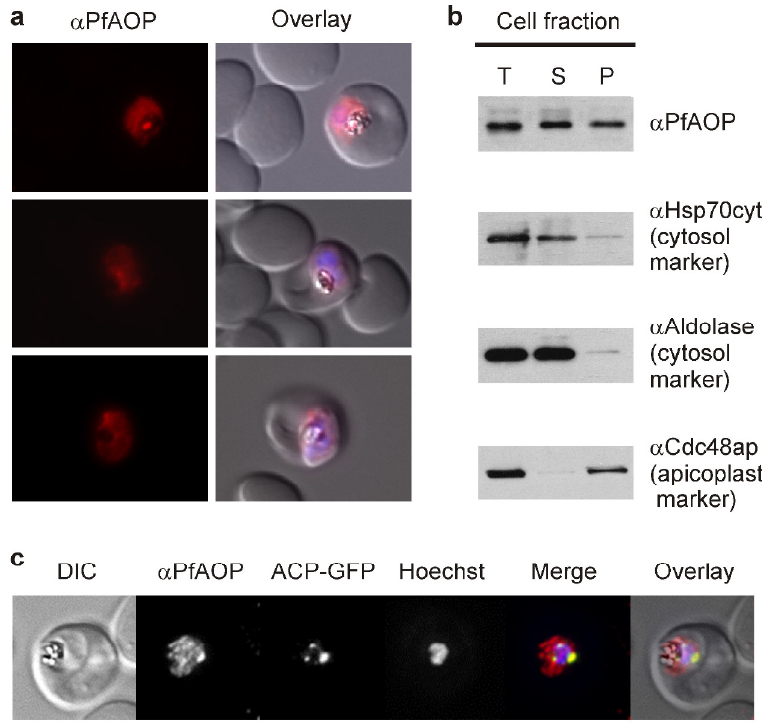
FIGURE 1: Dual localization of PfAOP. (A) Immunofluorescence localization of PfAOP in blood stage parasites. (B) Detection of PfAOP and marker proteins by western blotting after subcellular fractionation. The total parasite lysate (T), the supernatant (S) and the organel- lar pellet fraction (P) are shown from the left to the right side. PfAOP was detected at ap- proximately 22 kDa (Fig S1). Apicoplast Cdc48, Hsp70 and aldolase were detected at approxi- mately 130, 70 and 40 kDa, respectively. (C) Co-localization analysis of PfAOP and a chime- ra of acyl-carrier protein and GFP (ACP-GFP) as an apicoplast-localized marker